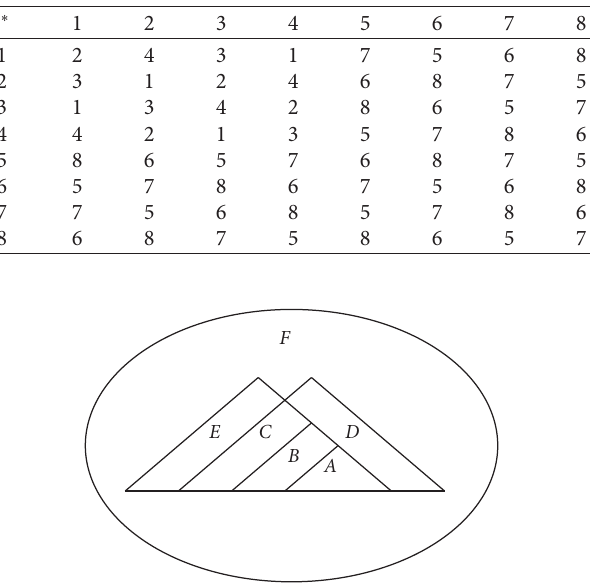
Figure 1: The relationships among AG- (l,l) -Loop and AG- (l,r )-